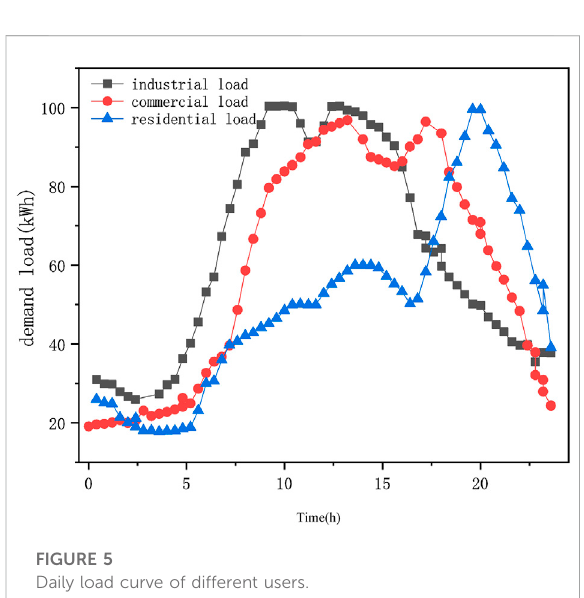
FIGURE 5 Daily load curve of different